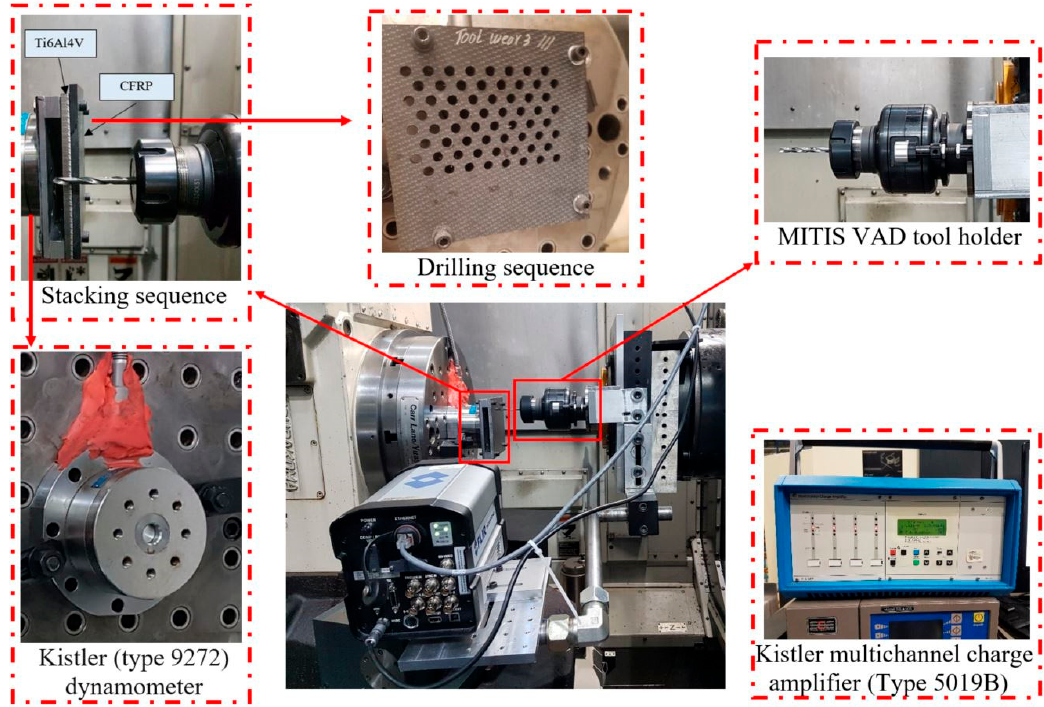
Figure 2. The experimental set-up, tool holder, drilling, and stacking sequence used during the